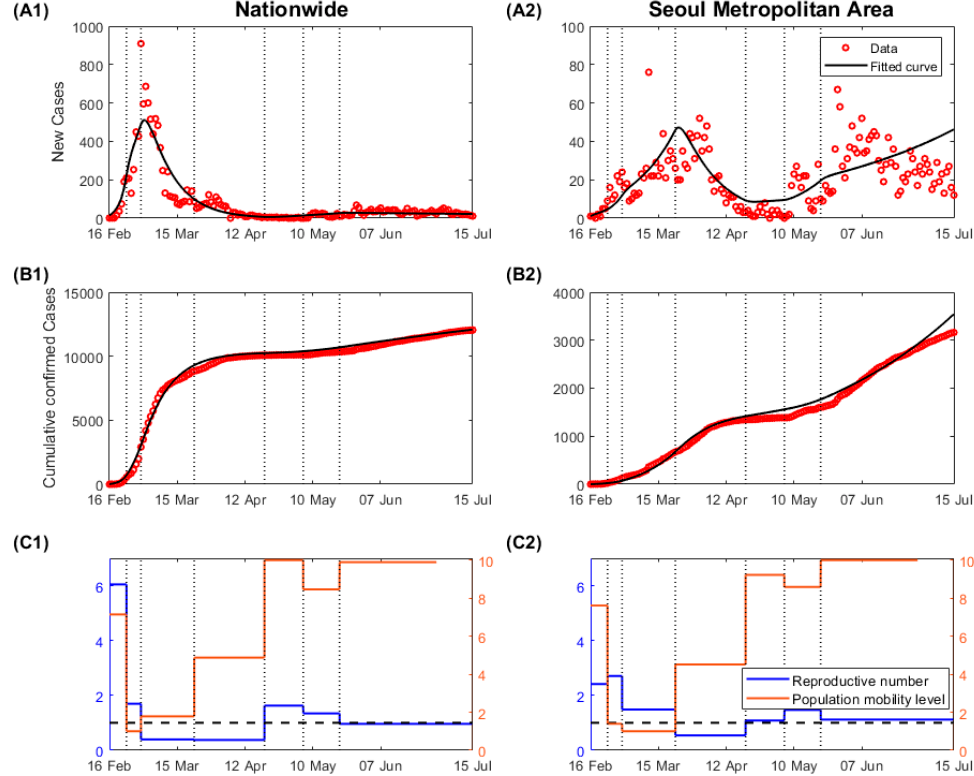
Figure 4. Data fitting results and projections, the reproductive number and population mobility levels according to the social distancing level: ( A ) daily confirmed cases; ( B ) cumulative confirmed cases; ( C ) reproductive number and population mobility level.